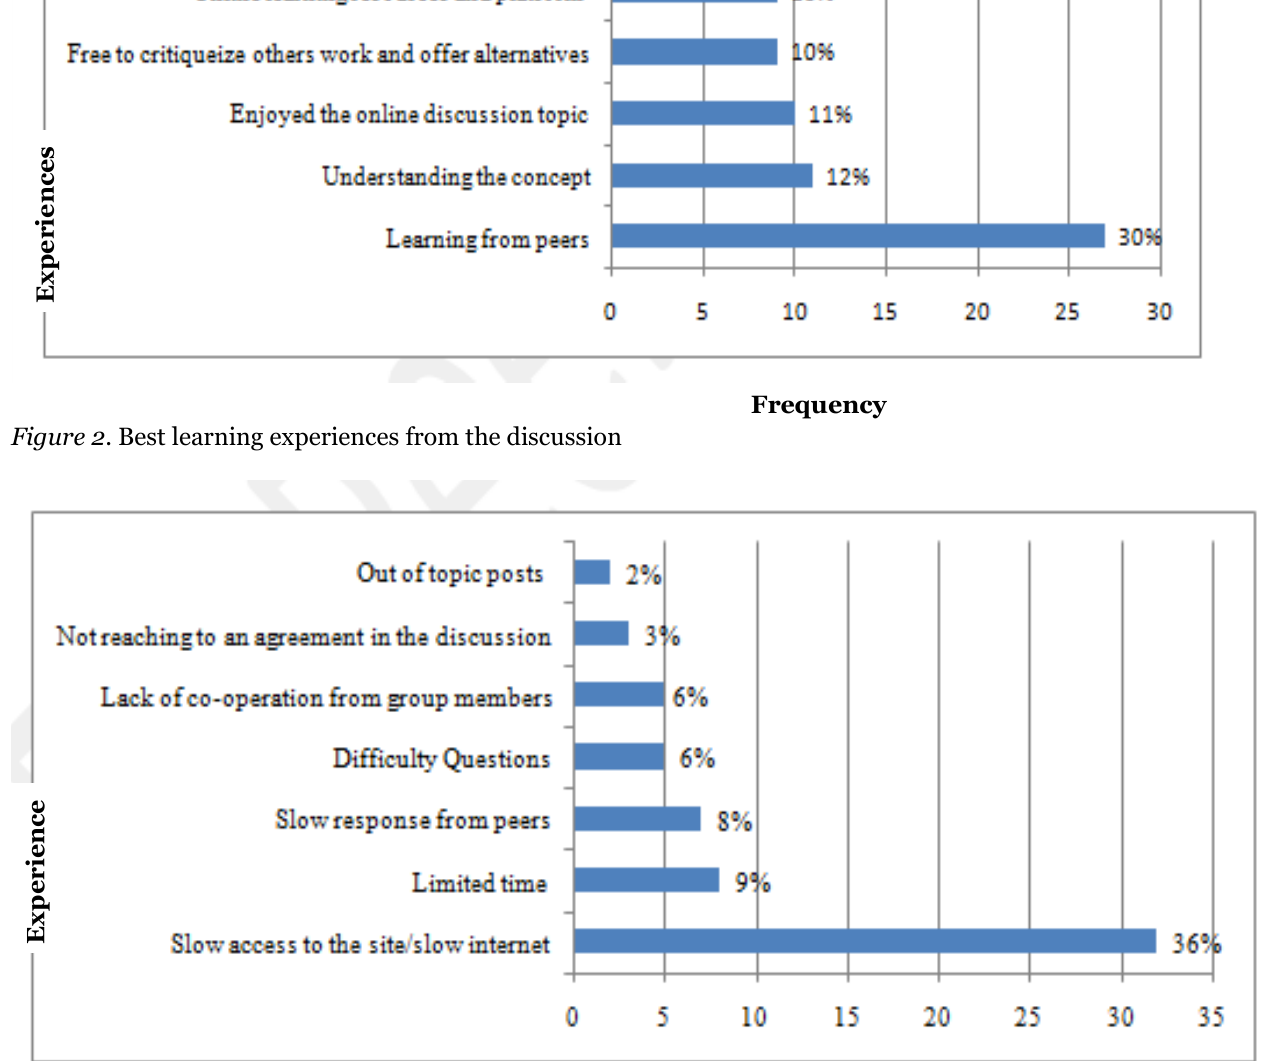
Figure 3. Worst experiences during the